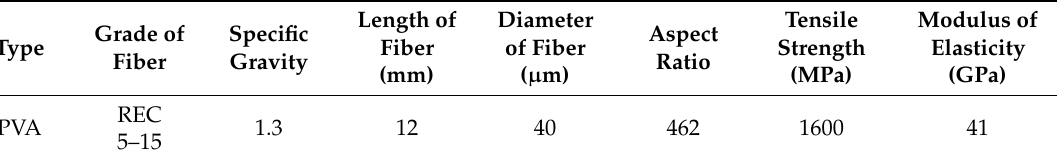
Table 2. Properties of PVA